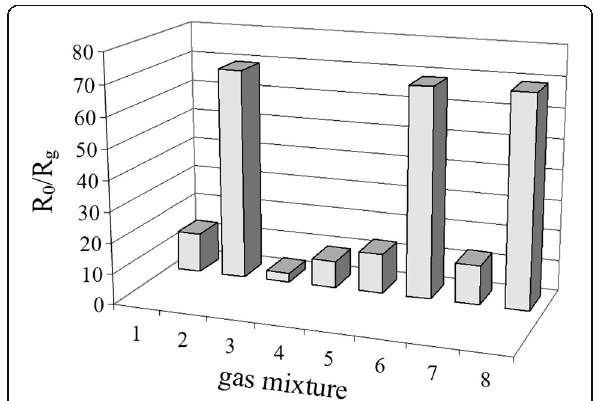
Fig. 8 Response of the sensor S 2 containing 0.09 wt% Pd ( T = 261 ° C) upon exposure to analyzed gas mixture of air with 1 20 ppm H 2 , 2 500 ppm H 3 500 ppm CH 4 500 ppm CO, 5 20 ppm H Fig. 9 Response to 40 ppm H 2 of the sensors S 2 (S-67 and S-69) 2 , 4 , 2 + 500 ppm CH based on 0.09% Pd/SnO 2 nanomaterial during 6 months of their operation at the sensor temperature 261